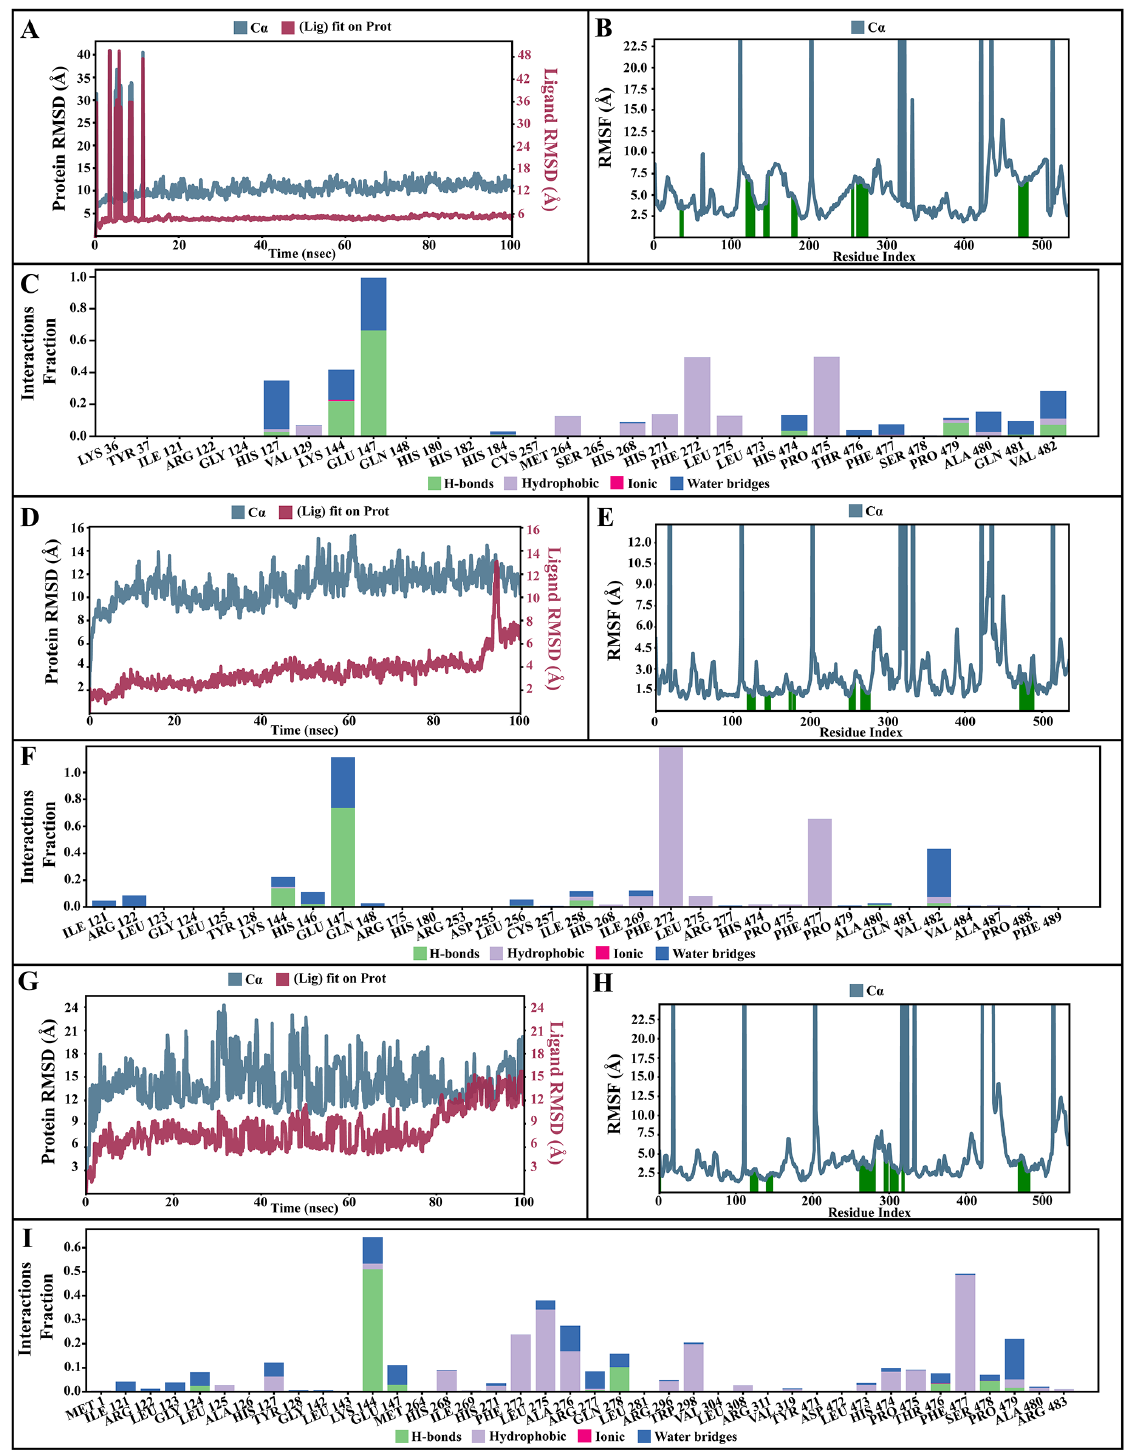
Figure 8. Simulation interactions diagram of pinocembrin, chrysin and tectochrysin with essential proteins. ( A–C ) Simulation interactions diagram of pinocembrin-AcSIR2 complex. (A) Plot of protein-ligand RMSD. ( B ) Plot of protein RMSF. ( C ) Histogram of protein- ligand contacts categorized by type of interactions: hydrogen bonds (green), hydrophobic (purple), ionic (magenta), and water bridges (blue). (D-F) Simulation interactions diagram of chrysin-AcSIR2 complex. ( D ) Plot of protein-ligand RMSD. ( E ) Plot of protein RMSF. ( F ) Histogram of protein-ligand contacts categorized by type of interactions: hydrogen bonds (green), hydrophobic (purple), ionic (magenta), and water bridges (blue). ( G–I ) Simulation interactions diagram of tectochrysin-AcSIR2 complex. ( G ) Plot of protein-ligand RMSD. (H) Plot of protein RMSF. ( I ) Histogram of protein-ligand contacts categorized by type of interactions: hydrogen bonds (green), hydrophobic (purple), ionic (magenta), and water bridges (blue). RMSD, root mean square deviation; RMSF, root mean square fluctuation; AcSIR2, A. castellanii Sir2 family